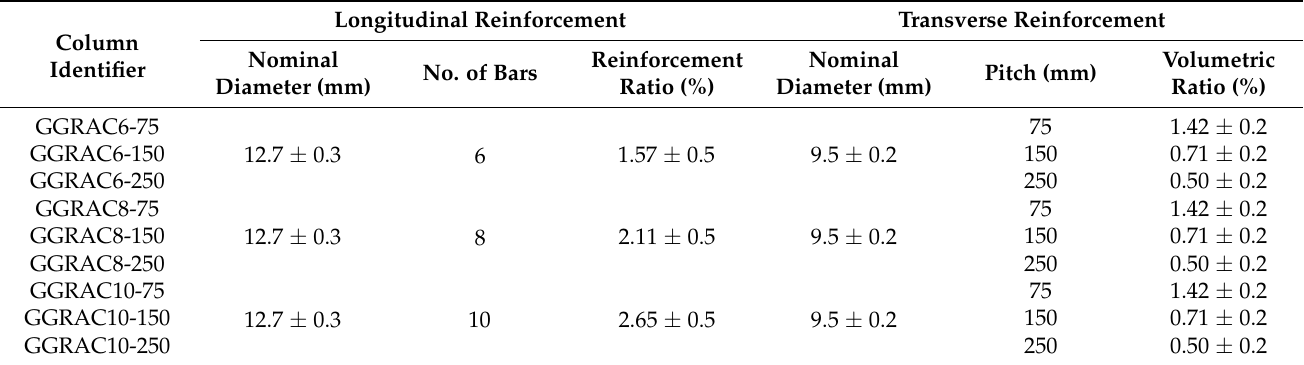
Table 4. Details of test compressive members.